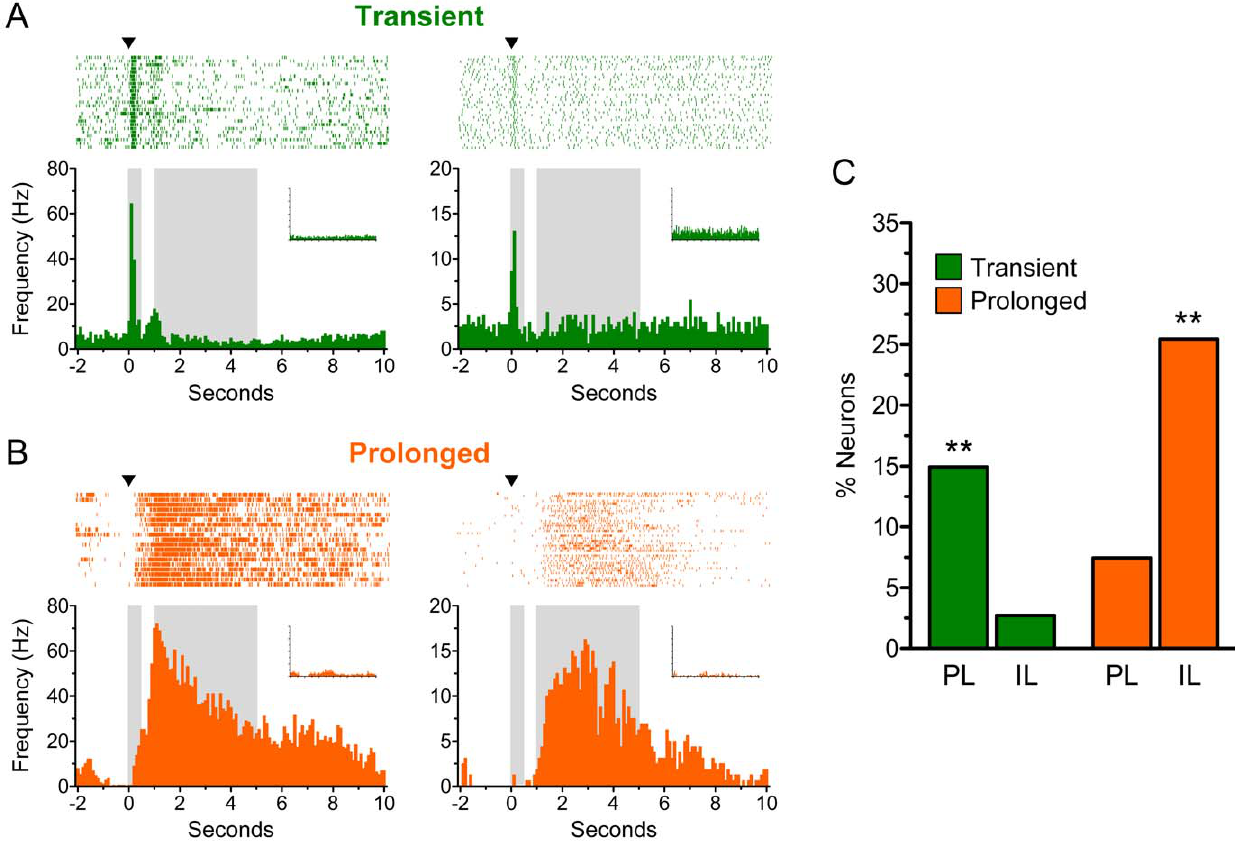
Figure 2. Transiently-responsive neurons predominated in PL, whereas prolonged-responsive neurons predominated in IL. A-B, Single-neuron examples of transient and prolonged excitatory responses during rewarded lever presses. Insets show the activity of these neurons during unrewarded presses, and gray boxes represent the temporal windows used to quantify the proportion of neurons showing each type of response. C, Percentage of neurons per structure that showed either transient or prolonged excitation during rewarded lever presses. PL exhibited significantly more transiently-responsive neurons than IL, whereas IL exhibited significantly more prolonged-responsive neurons than PL ( X 2 tests: **p ,